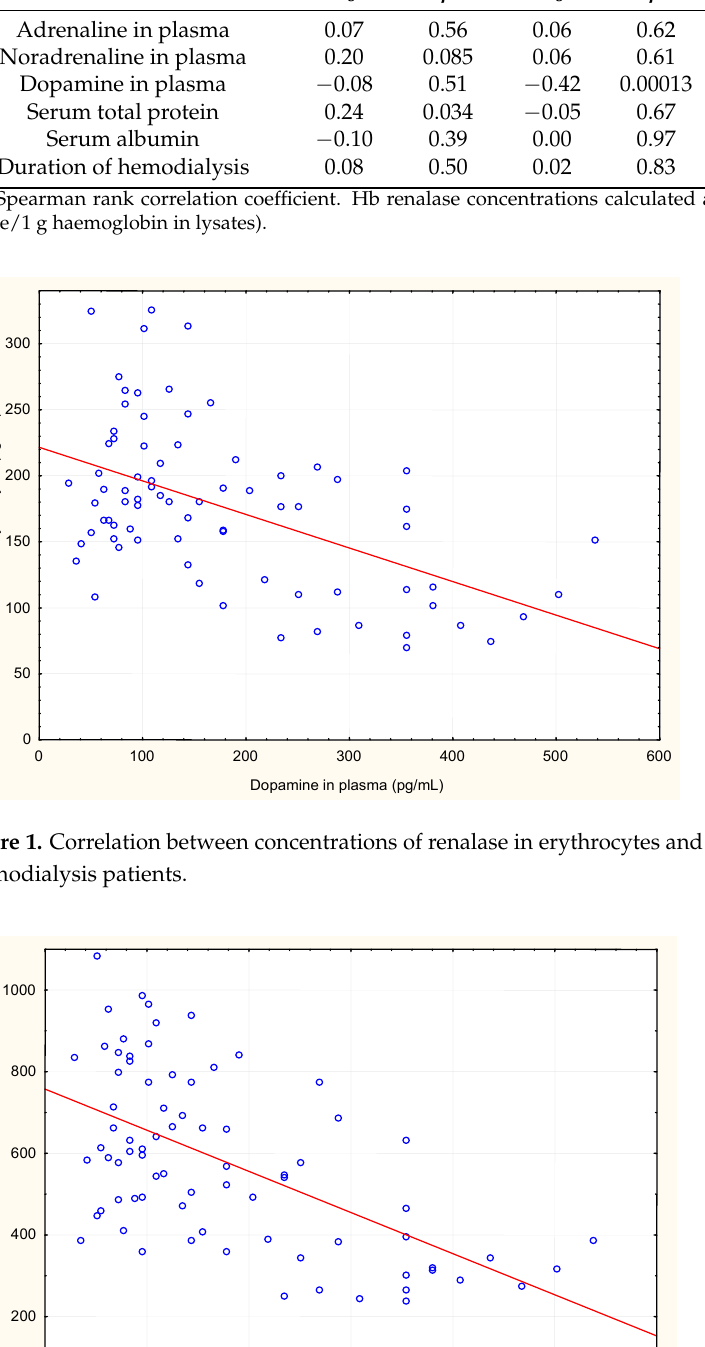
Table 2. Correlations between studied parameters in hemodialysis patients.